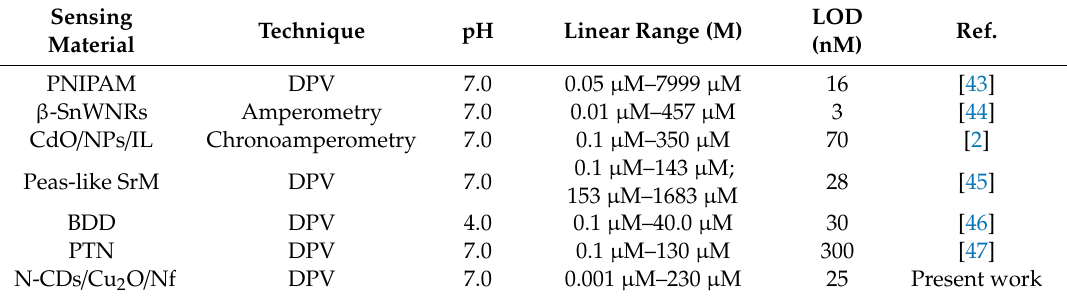
Figure 6. ( A ) Di ff erential pulse voltammograms of CPZ with di ff erent concentrations in 0.1 M PBS Figure 6. ( A ) Differential pulse voltammograms of CPZ with different concentrations in 0.1 M PBS (pH 7.0), ( B ) calibration plot of concentration of CPZ vs i p . (pH 7.0), ( B ) calibration plot of concentration of CPZ vs i p . Table 1. Comparison of the analytical merits of N-CDs / Cu 2 O / Nf composite with previously reported sensing materials for electrochemical determination of